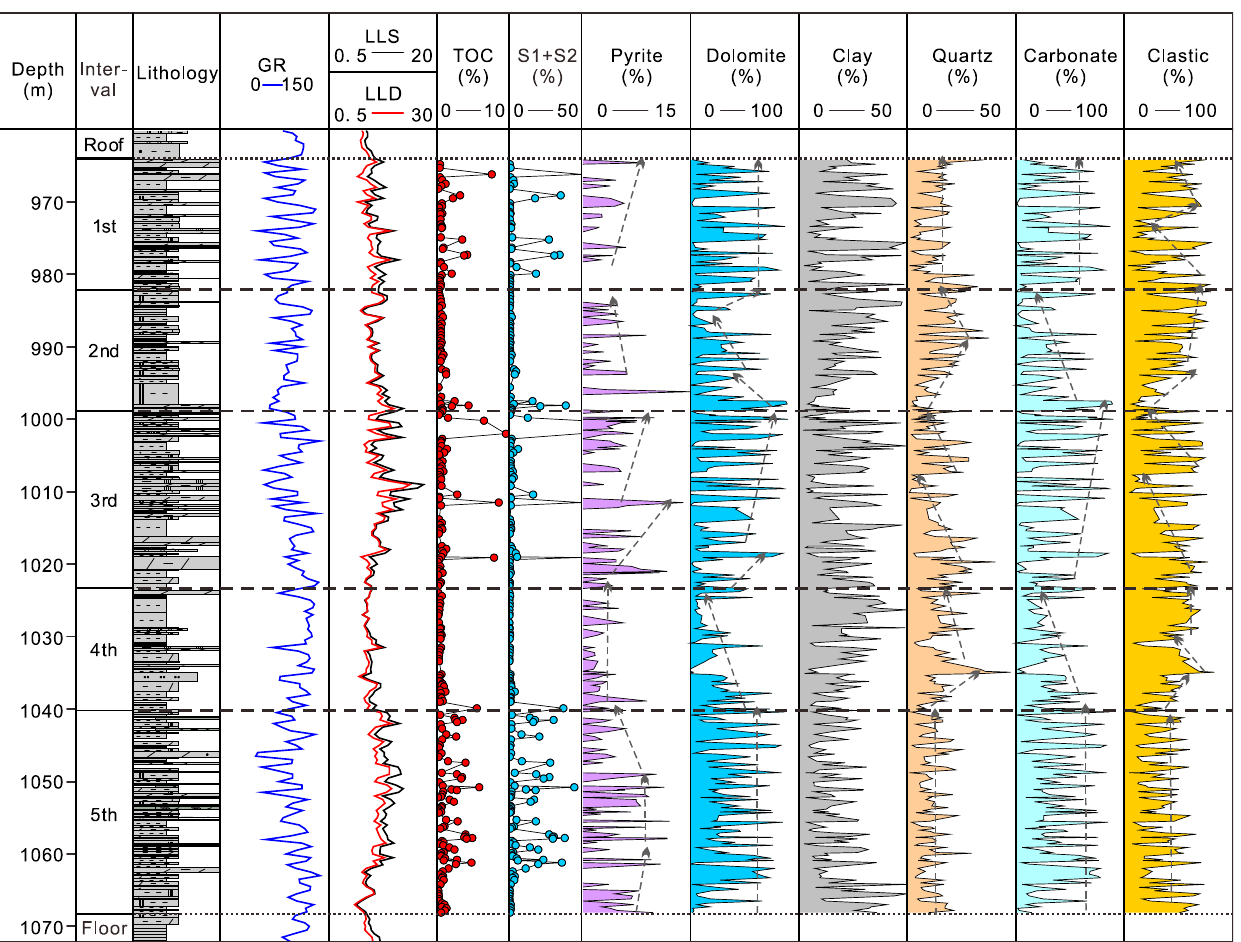
Figure 3. Lithological, geochemical, and mineralogical profiles of the LXF II Oil Bed in the Jianghan Basin. Clastic = Quartz + Feldspar + Clay.